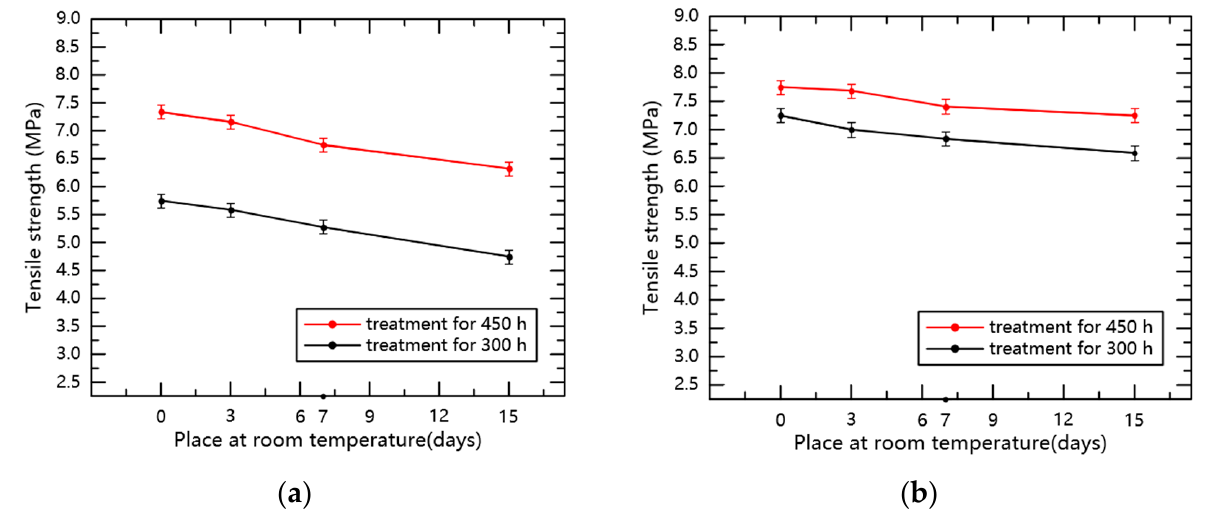
Figure 8. The relationship between the tensile strength of specimens and the days of storage at room temperature. ( a ) Silicone rubber; ( b ) Fluorosilicone rubber. After recovering for 0 to 15 days at room temperature, the tensile properties of the silicone rubber and fluorosilicone rubber samples recovered to a certain degree. Compared with low temperature treatment for 450 h, the tensile properties of the material treated for 300 h were closer to the state before treatment, but the samples still did not completely revert to the initial state. Moreover, the tensile properties of the fluorosilicone rubber specimens were always higher than that of the silicone rubber specimens. The main reason for the above experimental phenomenon is that the increase in tem- perature enhances the thermal motion of rubber molecules, and the activities of side groups and chain links intensify. The above two effects increase the distance between molecules and the volume of the sample, thereby reducing the intermolecular force.